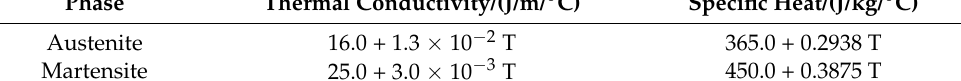
Table 4. Thermal conductivity and specific heat of 9310 steel.